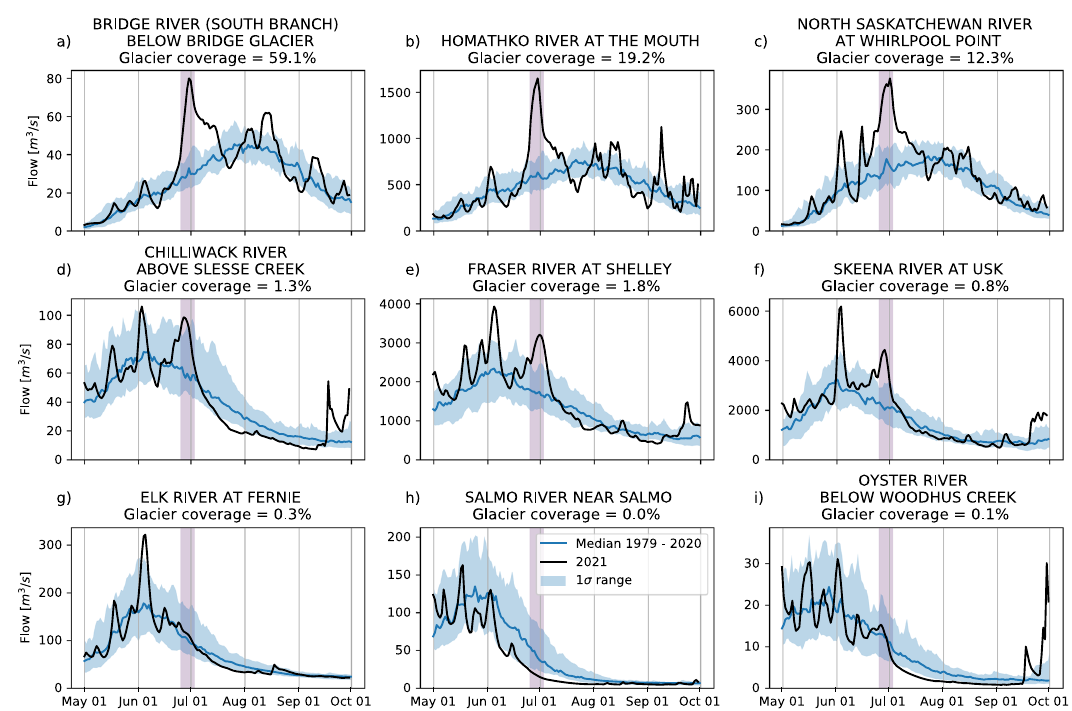
Fig.9|Heatwaveimpactsonstream fl ow. Stream fl owobservationsatninestream gaugestationsin2021(blackline)relativetothe1979 – 2020median(blueline)and 1 standard deviationrange(shaded). Gauges are organizedfrom top to bottomby